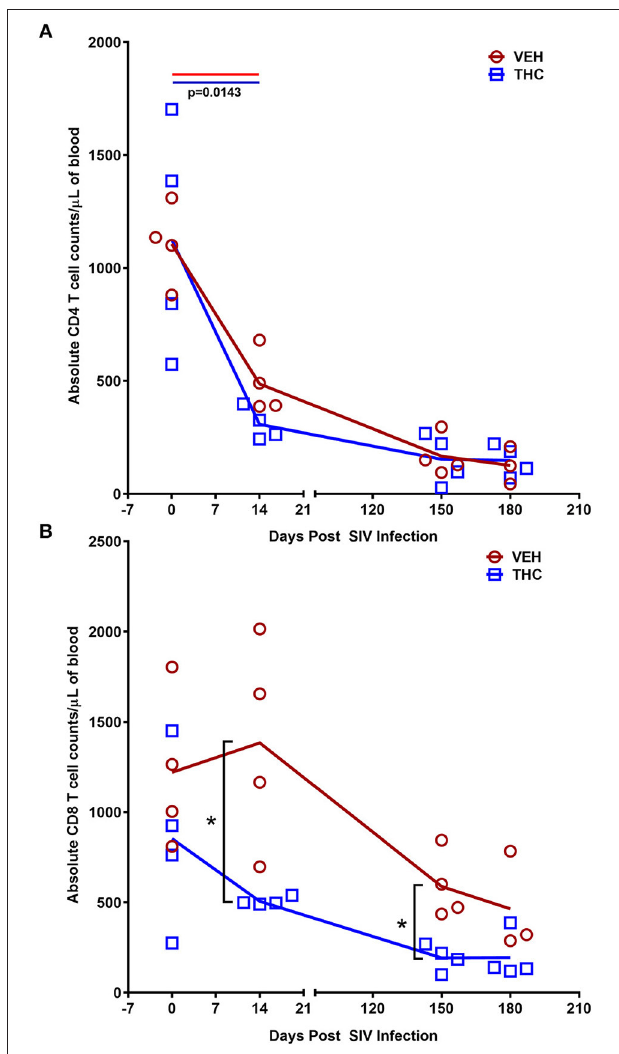
FIGURE 11 | Delta-9-tetrahydrocannabinol ( 1 9 -THC) administration inhibited CD8 + T cell expansion in peripheral blood during chronic SIV infection. Absolute counts revealed that Delta-9-Tetrahydrocannabinol ( 1 9 -THC) administration did not prevent depletion of CD4 + T cells (A) but significantly reduced total CD8 + T cell numbers (B) in peripheral blood at 14- and 150-days post-SIV infection. Note that CD8 + T cell data from only three VEH/SIV rhesus macaques were available at 180 days post-infection. Open red circles- VEH/SIV, Open blue squares- THC/SIV. Horizontal red and blue lines with P -values denote comparisons between time points within the VEH/SIV and THC/SIV groups, respectively. Left black brackets with an asterisk indicate statistical significance ( p = 0.0143) between the VEH/SIV and THC/SIV groups for a given time point. Connecting blue and red lines (A,B) denote mean values of the respective population in the THC/SIV and VEH/SIV groups, respectively. Flow cytometry analysis to determine the effect of 1 9 -THC on peripheral blood T cell dynamics in SIV-infected rhesus macaques was performed once with three to four individual animals as biological replicates per group. Flow cytometry data were analyzed using linear mixed models with immune-marker outcomes being dependent variables, and treatment status (VEH vs. 1 9 -THC) and days since the start of treatment (0, 14, 150, 180) being dependent variables with fixed effects. Differences between two post-infection time points were analyzed using the Mann-Whitney U -test employing the Prism v5 software (GraphPad software). A p -value ≤ 0.05 was considered